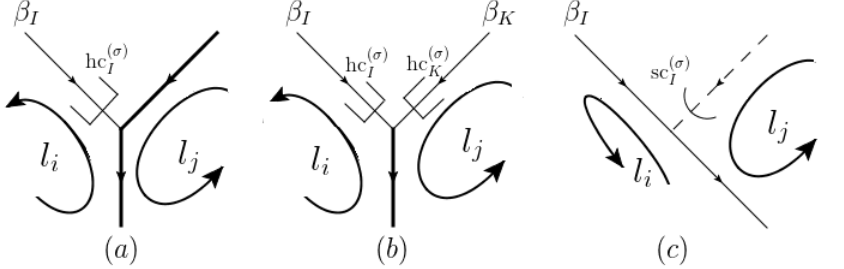
or l (cid:22) (or both) is projected i j